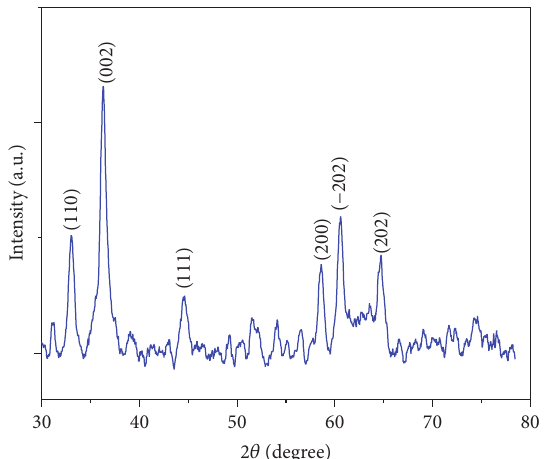
Figure 4: XPS spectra of as-synthesized CuO nanoparticles.